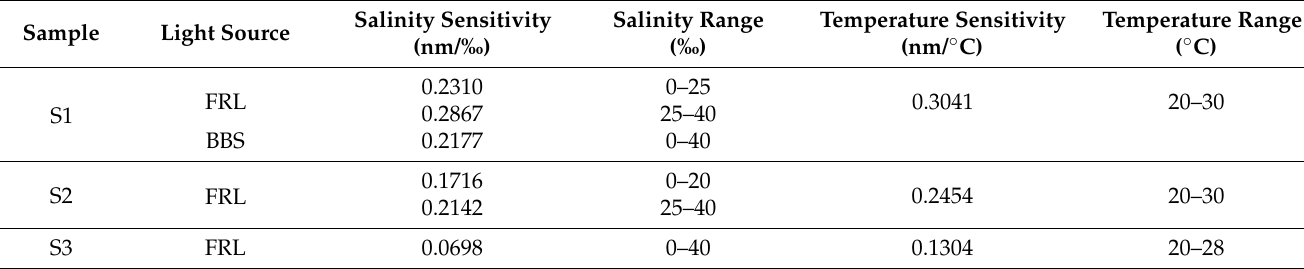
Table 2. Summary of the experimental results of each sensor.